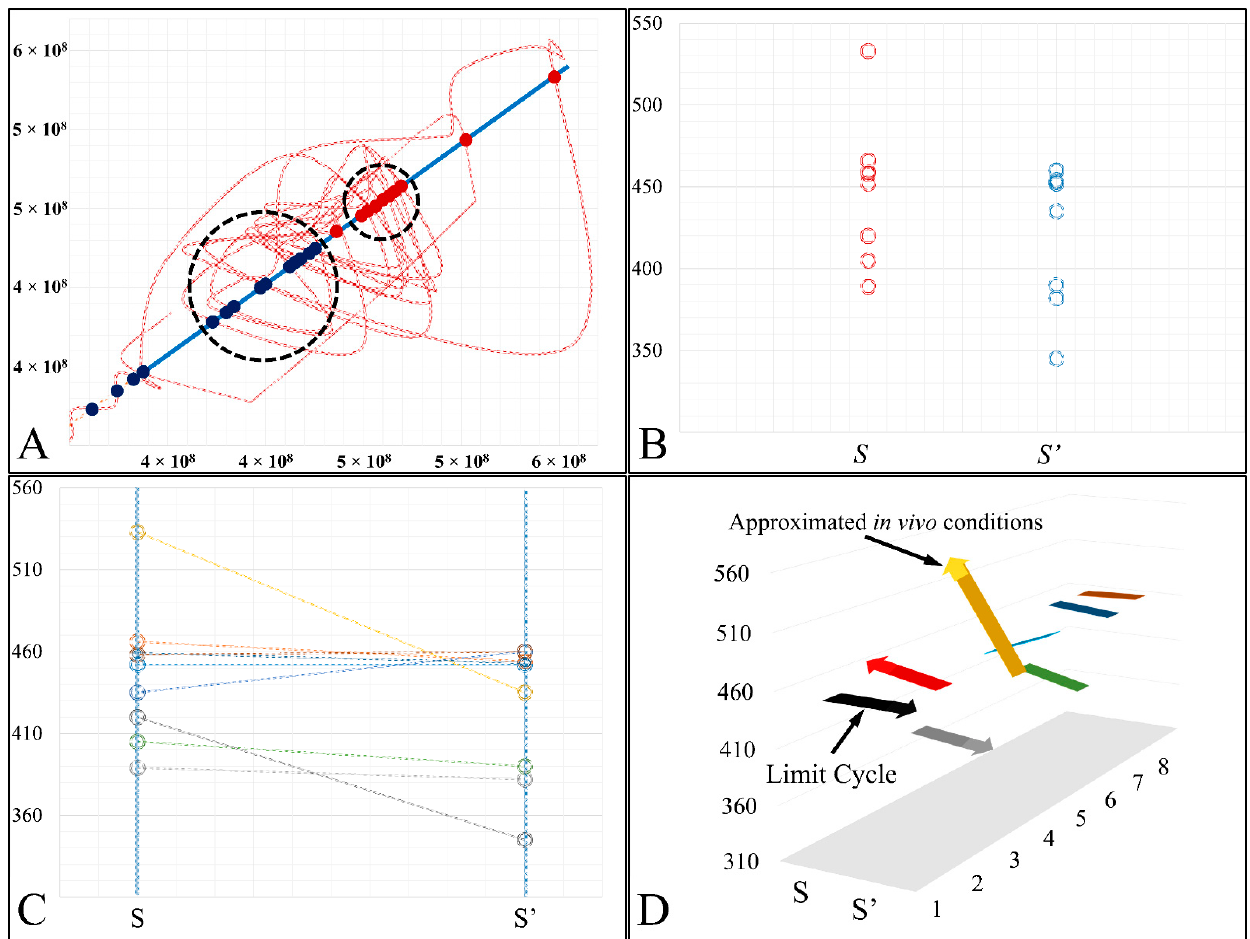
Figure 13. The Poincaré map cross-sections. We have presented all sections of the trajectory on the diagonal ( A ), along with the transmission points of S → S ′ ( B ), as well as the respective points with their mapping from S onto S ′ ( C ). Finally, the 3D representation of the cross-sections along with the cell populations is presented ( D ). The x -axis corresponds to the population of cells at time t and the y -axis corresponds to the population of cells at time t + 1.